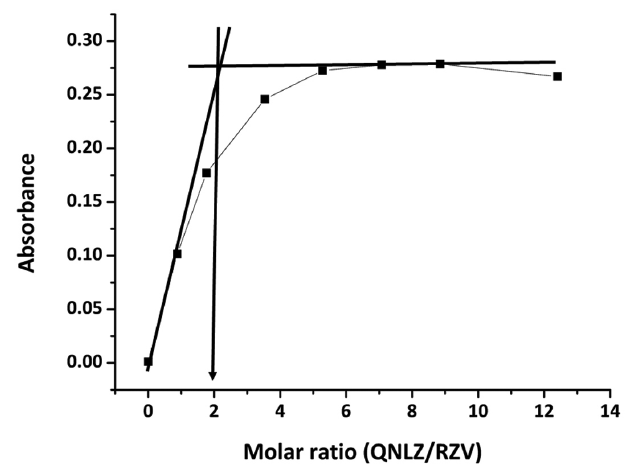
FIGURE 6 - Aplication of the molar ration technique to determine the stoichiometry of the charge transfer reaction. Experimental conditions: rosuvastatin: 20 mg L -1 and DMSO: 75% (v/v).